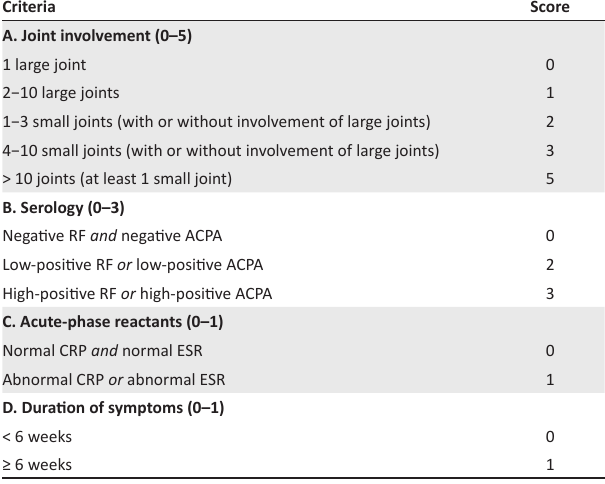
TABLE 2: The 2010 American College of Rheumatology/European League against Rheumatism classification criteria for rheumatoid arthritis. 26 Criteria Score